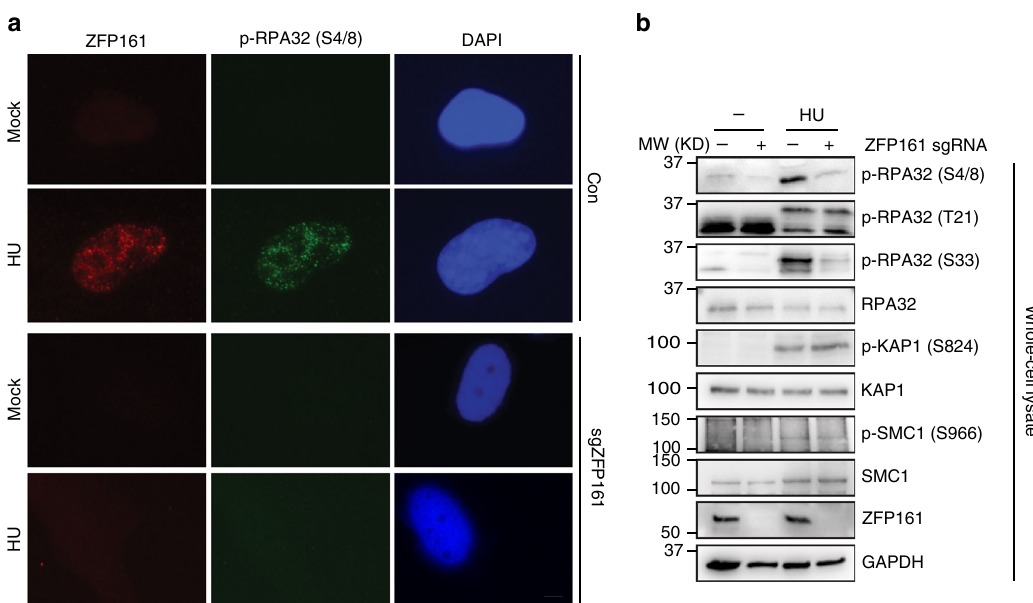
Fig. 3 ZFP161 is important for ATR activation. a The co-localization of phospho-RPA32 (S4/S8) and ZFP161 was determined by immuno fl uorescence in control or ZFP161-de fi cent cells. b After 10 mM HU treatment for 2 h, phosphorylation of DNA damage related proteins was determined by immunoblotting in ZFP161-knockout HCT116 cells. Scale bars, 10 µ m. Source data are provided as a Source Data fi